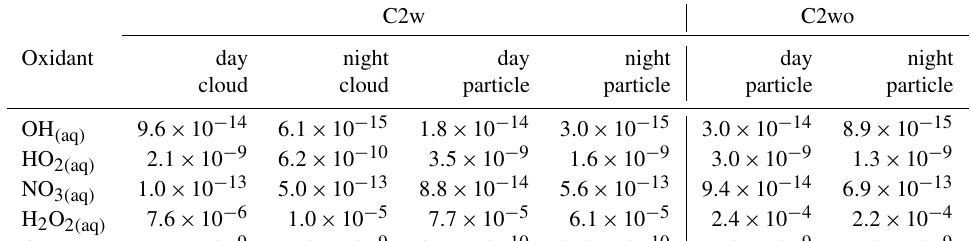
Table 2. Average aqueous-phase concentrations (molL − 1 ) of modeled radical and non-radical oxidants in different simulations.